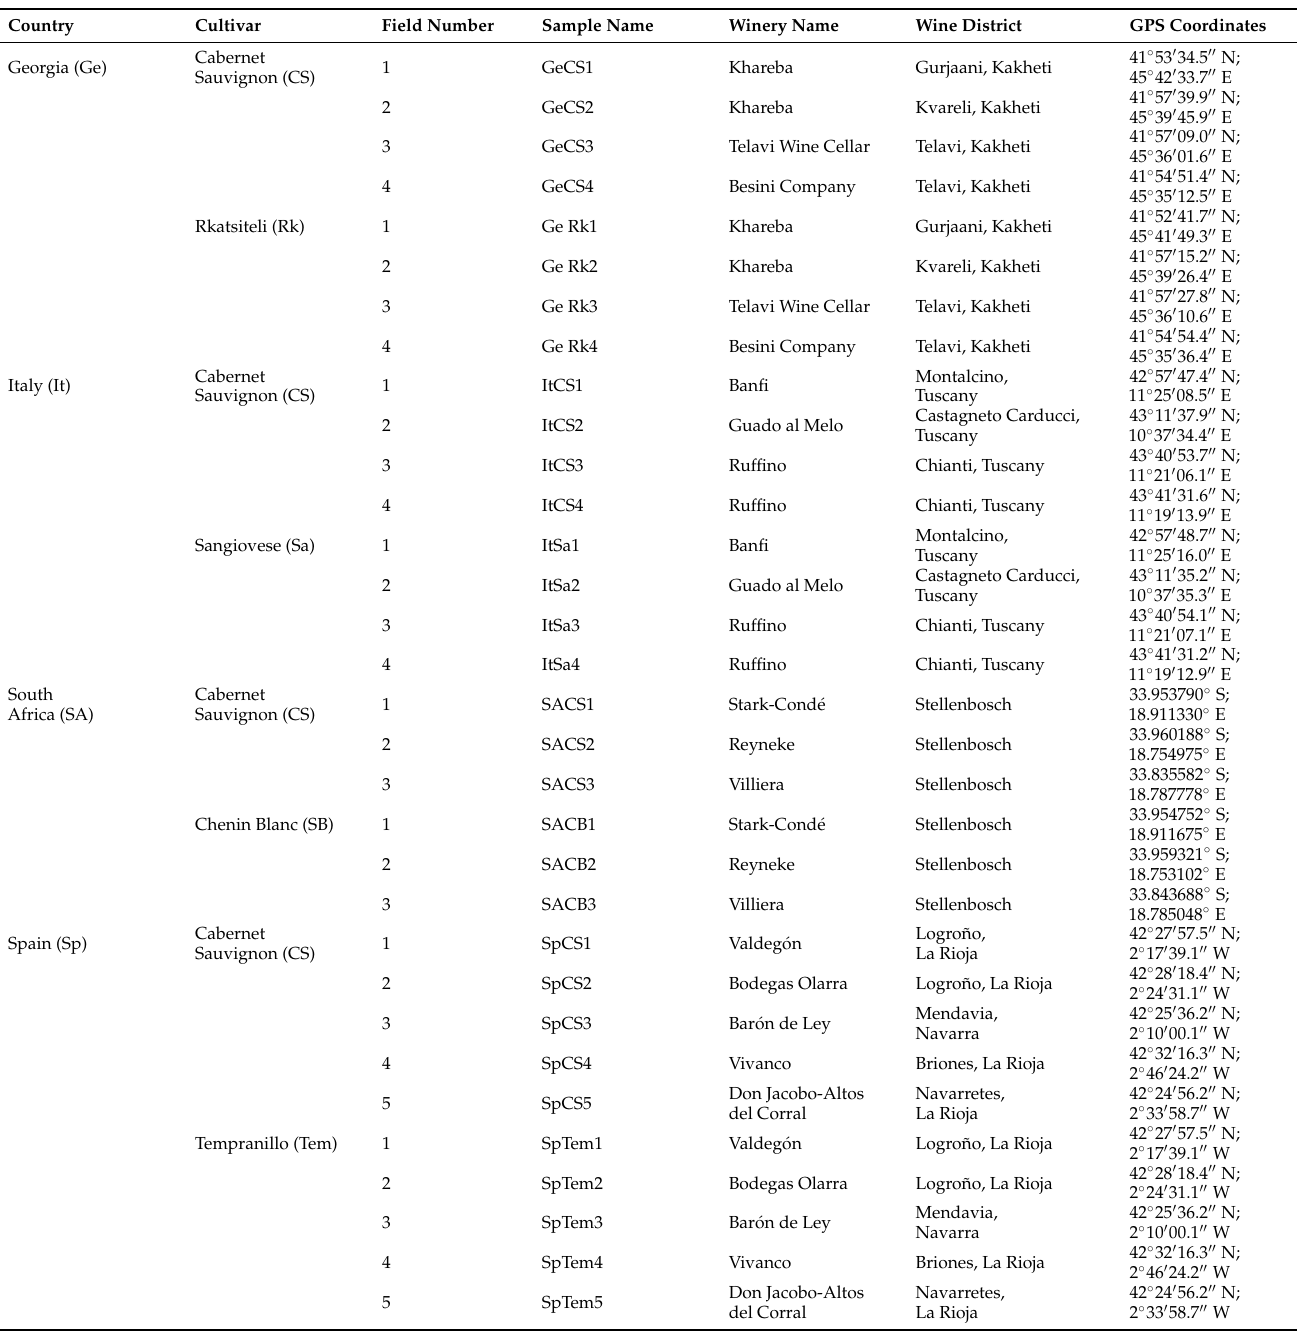
Table A1. Origin and geographic data of the grape